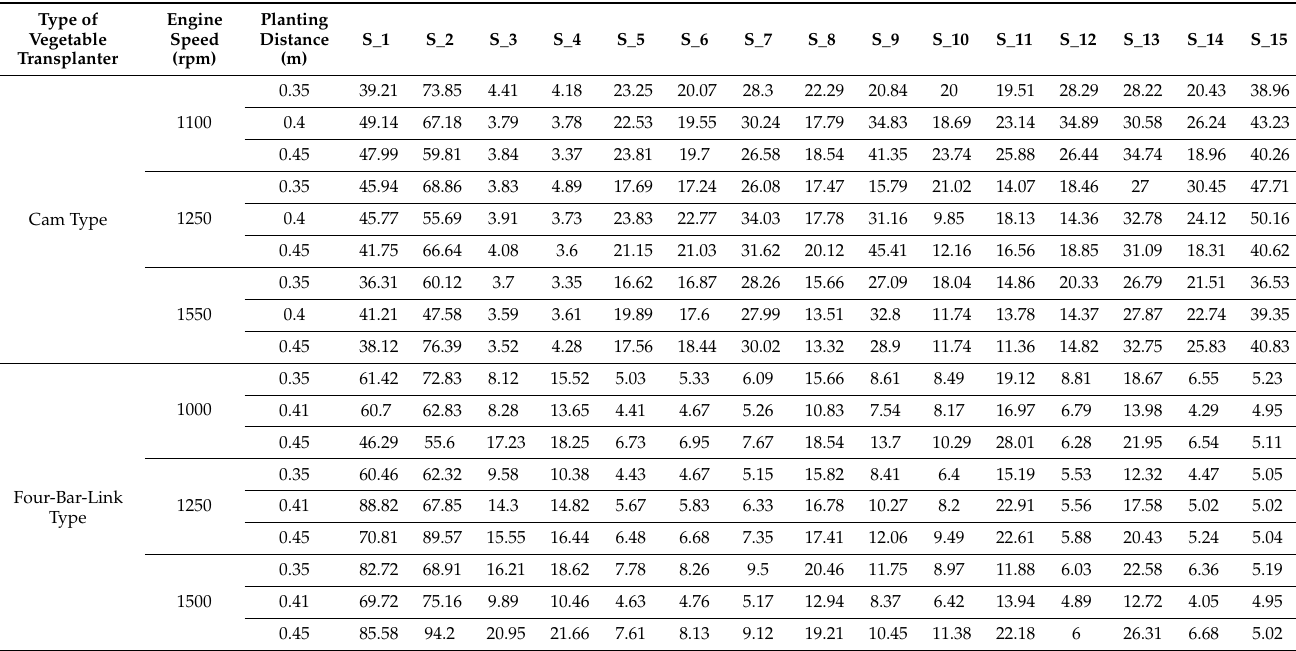
Table 5. Static safety factor on every spot of strain gauge in cam and four-bar-link types of vegetable transplanters under each working